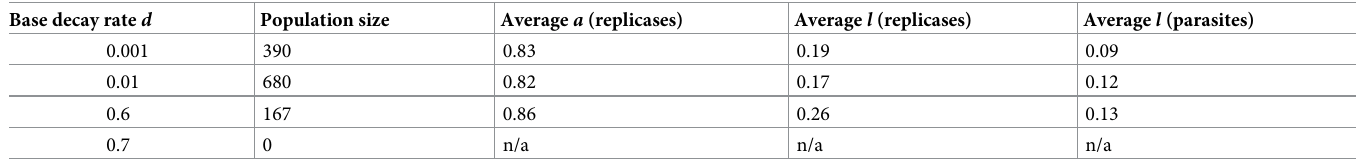
Table 3. System parameters values after 10000 steps of simulation in case of different values of base decay rate d (Scenario 4). Base decay rate d